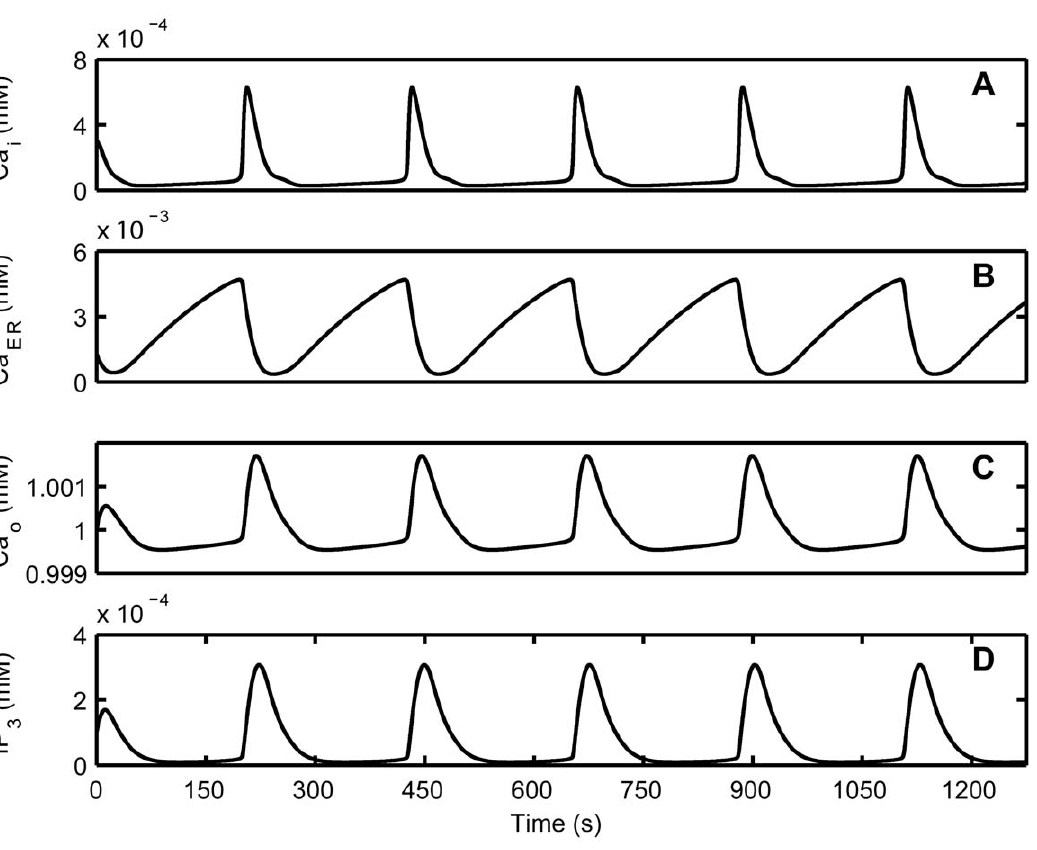
Figure 2. Characteristics of spontaneous Ca 2 + oscillations (CASs) in the computerized astrocytic model. (A) Ca 2 + oscillations in the ICS occur without any stimulus. (B) Ca 2 + oscillations in the ER occur earlier and last longer than those in the ICS. (C) The concentration of Ca 2 + in the ECS decreases slightly before Ca 2 + oscillations in the ICS and then increases after the oscillations. (D) IP 3 oscillates in the ICS.